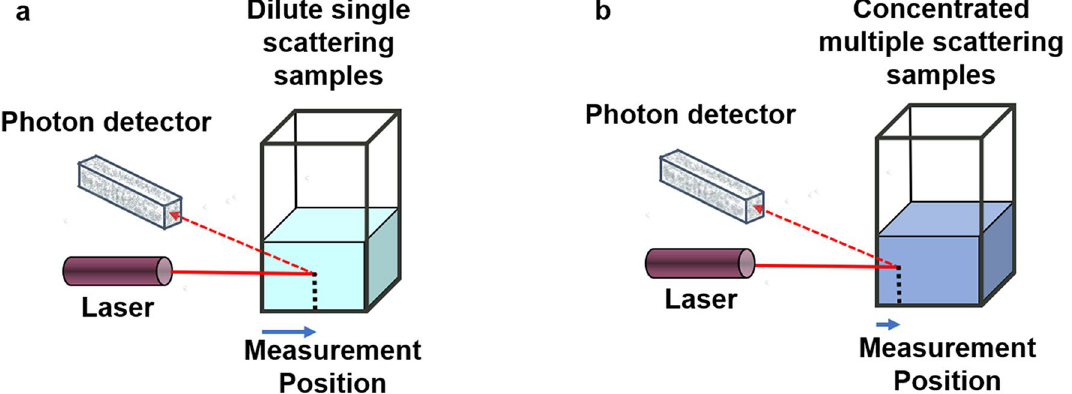
Figure 1. Schematic detailing the Non-Invasive Back Scatter (NIBS) optical configuration with the laser and the photon detector on the same horizontal plane perpendicular to the vertical direction of the cuvette and the automated measurement positioning process used to accommodate high concentration dynamic light scattering measurements with the Zetasizer for dilute samples ( a ) detection at the cuvette center, for turbid sample ( b ) close to the cuvette wall.